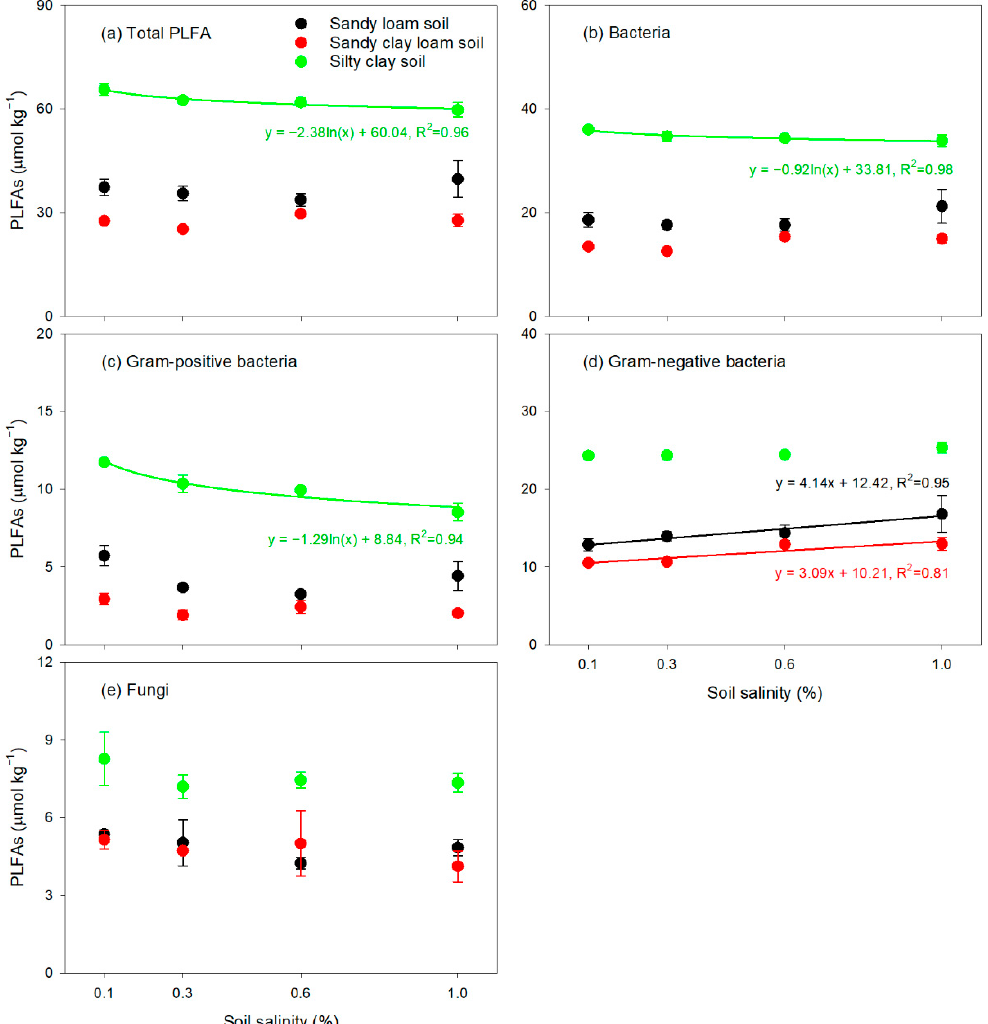
Figure 4. Relationships of total PLFAs ( a ), PLFA-distinguishable bacteria ( b ), Gram-positive bacteria ( c ), Gram-negative bacteria ( d ) and fungi ( e ) with salinity in the sandy loam soil, sandy clay loam soil and silty clay soil. Error bars indicate the standard error of the mean ( n = 3).